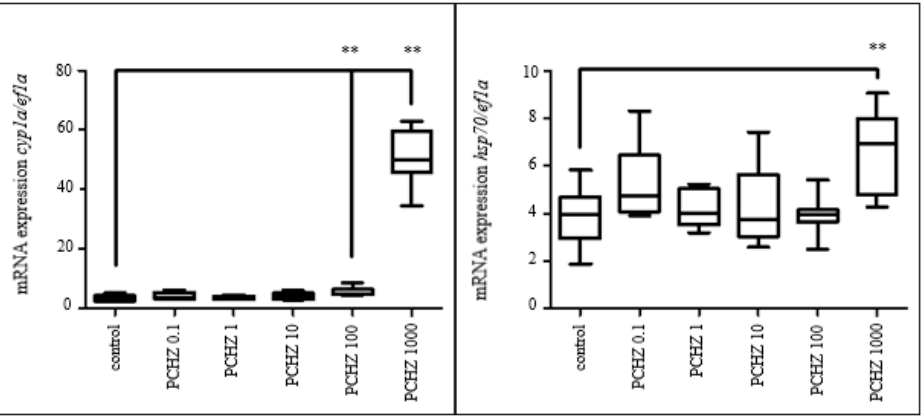
Figure 10. Relative mRNA expression of selected genes in C. carpio larvae exposed to PCZ. Concen- trations are indicated in µ g/L. Box plot graphs were constructed using median, Q1, and Q2 with whiskers of a maximum 1.5 interquartile range. Statistically significant differences are indicated by ** ( p <